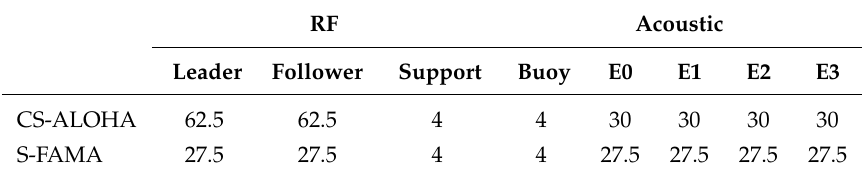
Table 1. Throughput (Bytes per second) of each packet flow stream during the second experiment. RF Acoustic Leader Follower